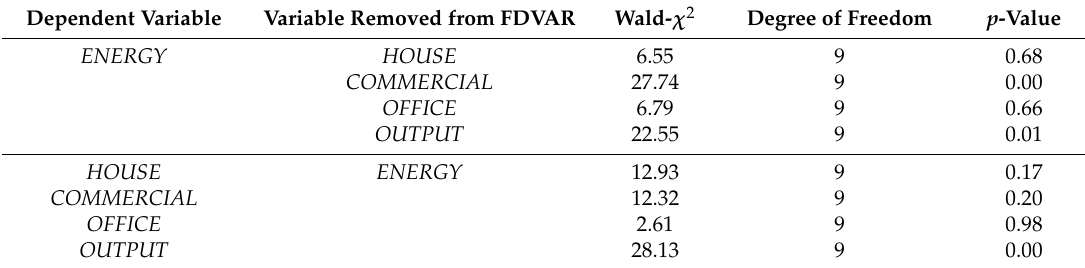
Table 7. Granger causality